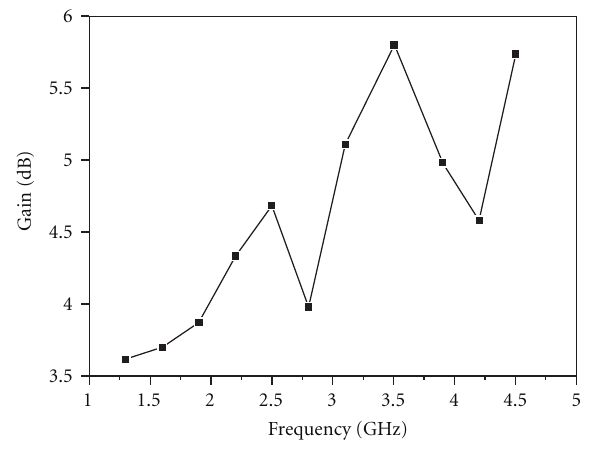
Figure 5: Gain against